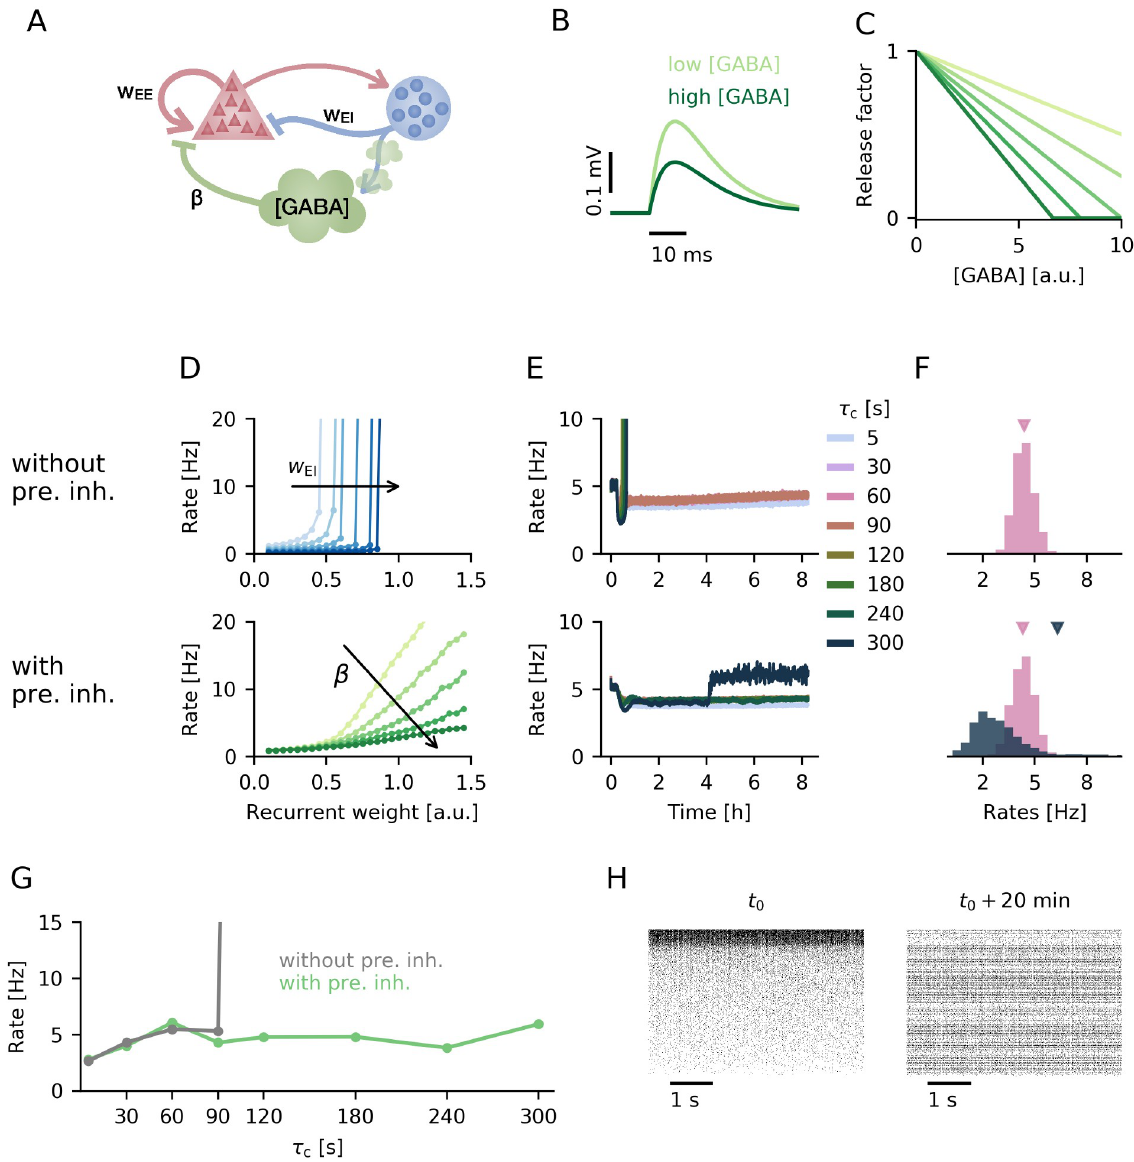
Fig 4. Presynaptic inhibition in a spiking network. A . Circuit diagram of the spiking network model consisting of an excitatory and inhibitory population of neurons as well as accumulation of local GABA concentration that triggers presynaptic inhibition. B . EPSP amplitude in the presence of presynaptic inhibition ( β = 0.1) for low and high GABA concentration (1 and 5, respectively). C . Release factor as a function of GABA concentration for different examples of linear transfer functions. D . Population firing rate as a function of mean excitatory recurrent weight for increasing strengths of postsynaptic inhibition w EI (top) or presynaptic inhibition β (bottom). E . Temporal evolution of the population firing rate for different homeostatic time constants τ c in networks without (top) and with presynaptic inhibition (bottom). F . Final firing rate distribution for two example runs: τ c = 60s (pink) and τ c = 120s (dark blue-grey) without (top) and with presynaptic inhibition (bottom). Average firing rate is indicated by triangle of respective colour. G . Mean final population rate as a function of homeostatic time constant. H . Raster plot of 1000 random neurons in the networks sorted by activity at time t 0 (left) and with the same ordering 20 minutes of simulation time later.